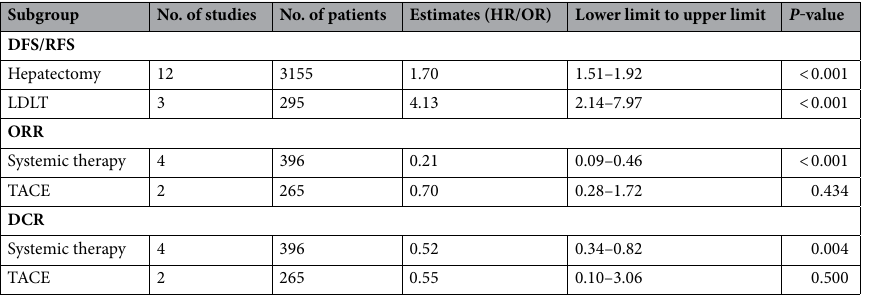
Table 3. Subgroup analyses of recurrence and tumor response. LDLT Living-Donor Liver Transplantation, TACE transarterial chemoembolization, DFS disease-free survival, RFS recurrence-free survival, ORR objective response rate, DCR disease control